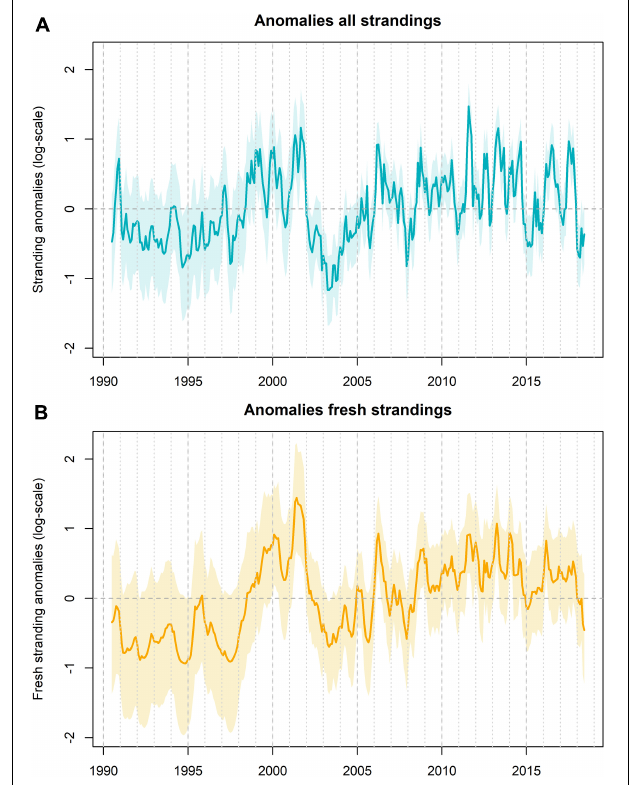
FIGURE 5 | Temporal pattern in the observed and predicted strandings. The top figure (A) shows the temporal pattern in sightings used to predict the stranding rate. The middle figure (B) represents the observed (vertical bars) and expected number of all stranded porpoises based on a model relying solely on the sighting rate in August (red line). The bottom figure (C) represents the observed (vertical bars) and expected number of fresh and alive stranded porpoises.